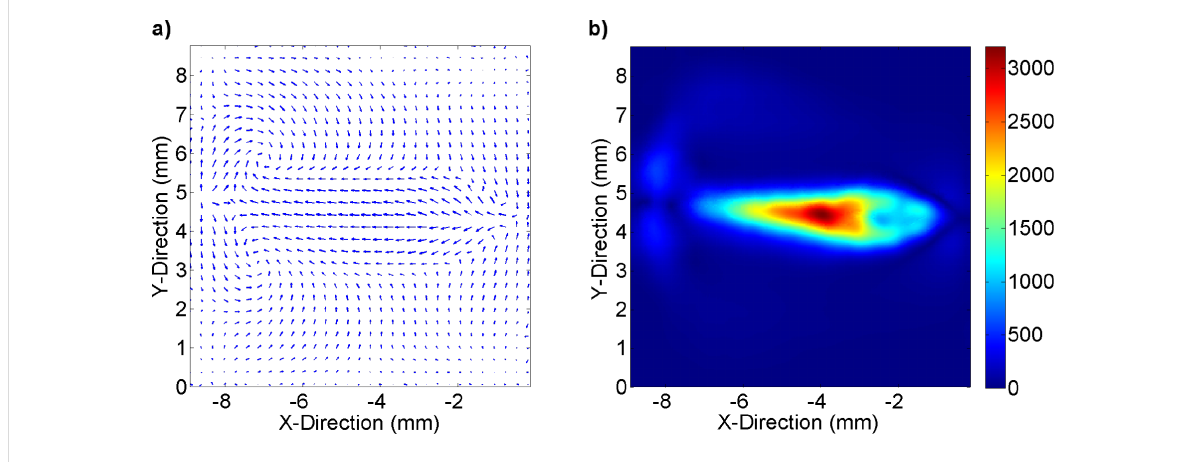
Figure 3: a) The velocity profile at a distance of z = 10 μ m from the chamber bottom. The vector length scales with the normalized logarithmic velocity. b) The color code indicates the respective bottom shear rate in s − 1 .